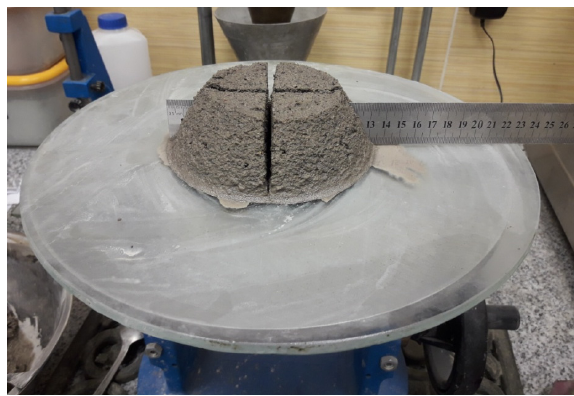
Figure 7. Slump flow